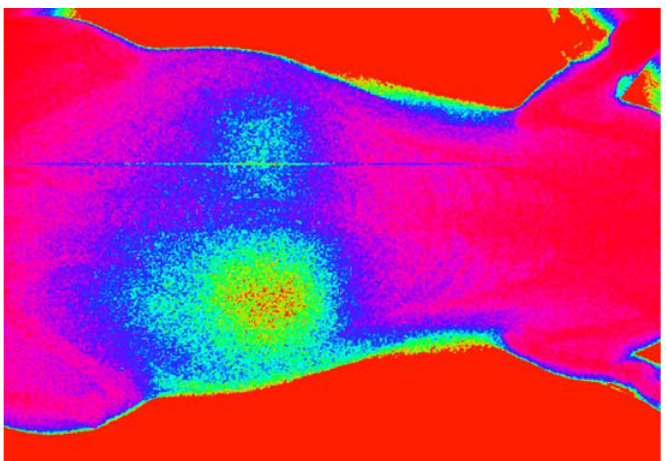
FIGURE 1 - Scintigraphic image after seven days of I/R, from control group rat (without the use of sildenafil), showing a large reduction of the radiotracer uptake in the left kidney (functional deficit), when compared with the right kidney.